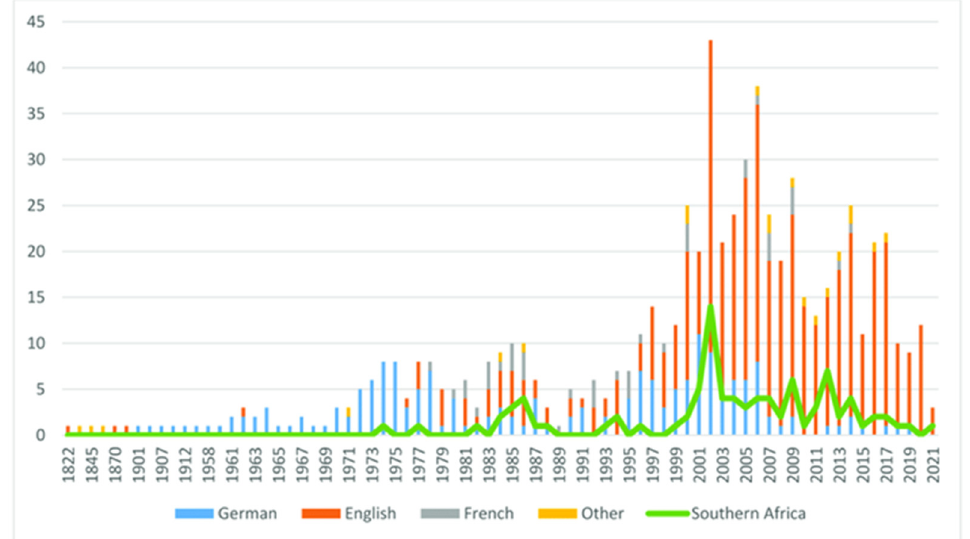
Figure 5. Number of research papers on Harpagophytum spp., 1822–2021 (publication language/origin of research) [28].